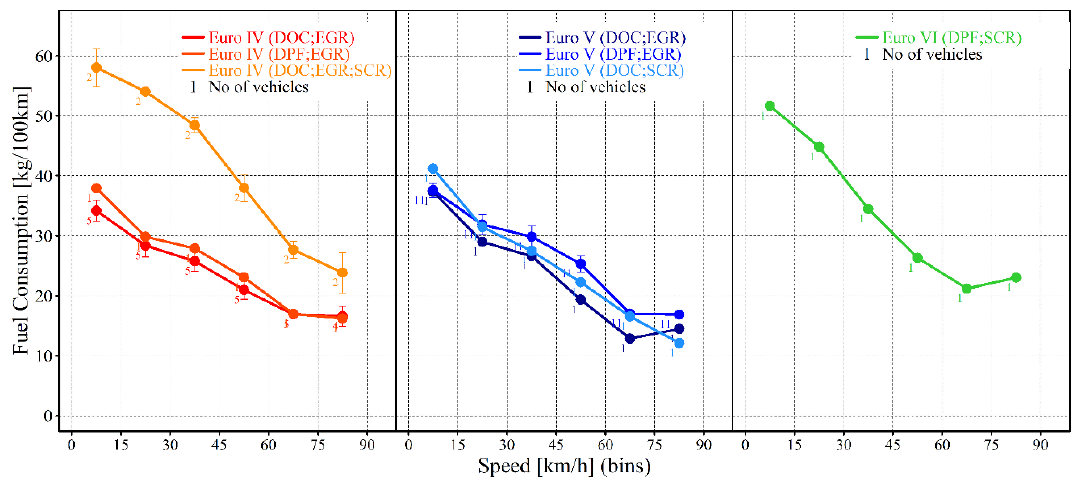
Figure A4. Sample mean and ± one standard error limits of the distance-based FC levels over speed (500m driving sequences).